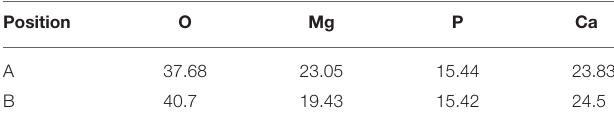
TABLE 2 | EDS results of the E330 alloys after immersion in SBF for 120h (wt.%). Position O Mg P Ca